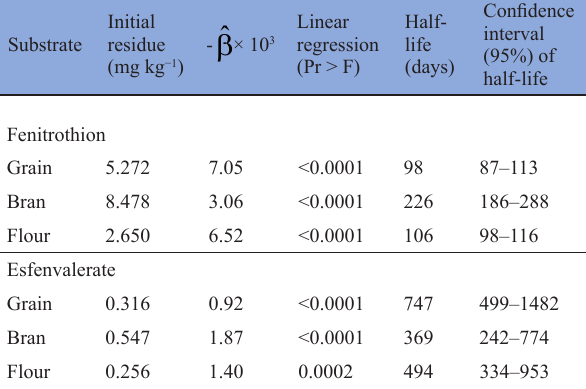
Table 3. Fenitrothion and esfenvalerate residues in treated wheat grains, bran, and flour, estimates of the parameter β of the degradation regression, and the mean half-life of the active ingredient based on